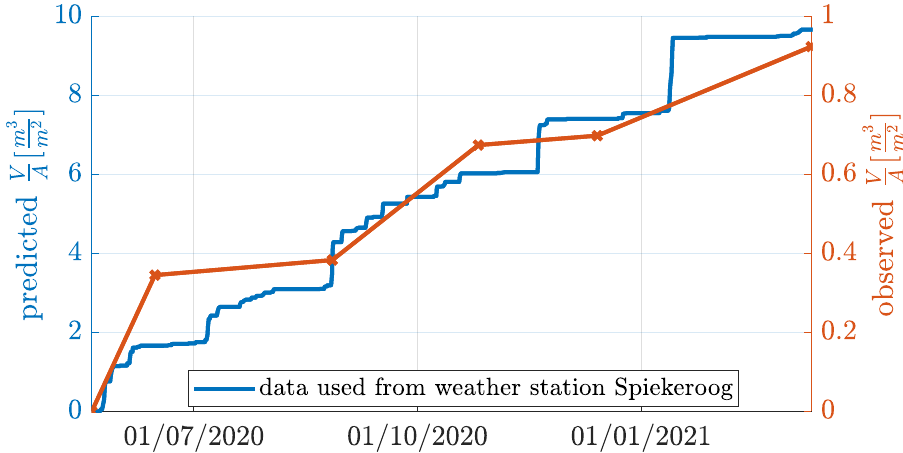
Figure 9. Predicted dune toe volume changes based on transportation equation using wind data from Spiekeroog weather station (blue line) and observed volume changes (orange line) for Langeoog study site (reproduced with permission from Eichmanns and Schüttrumpf (2021) [29]).